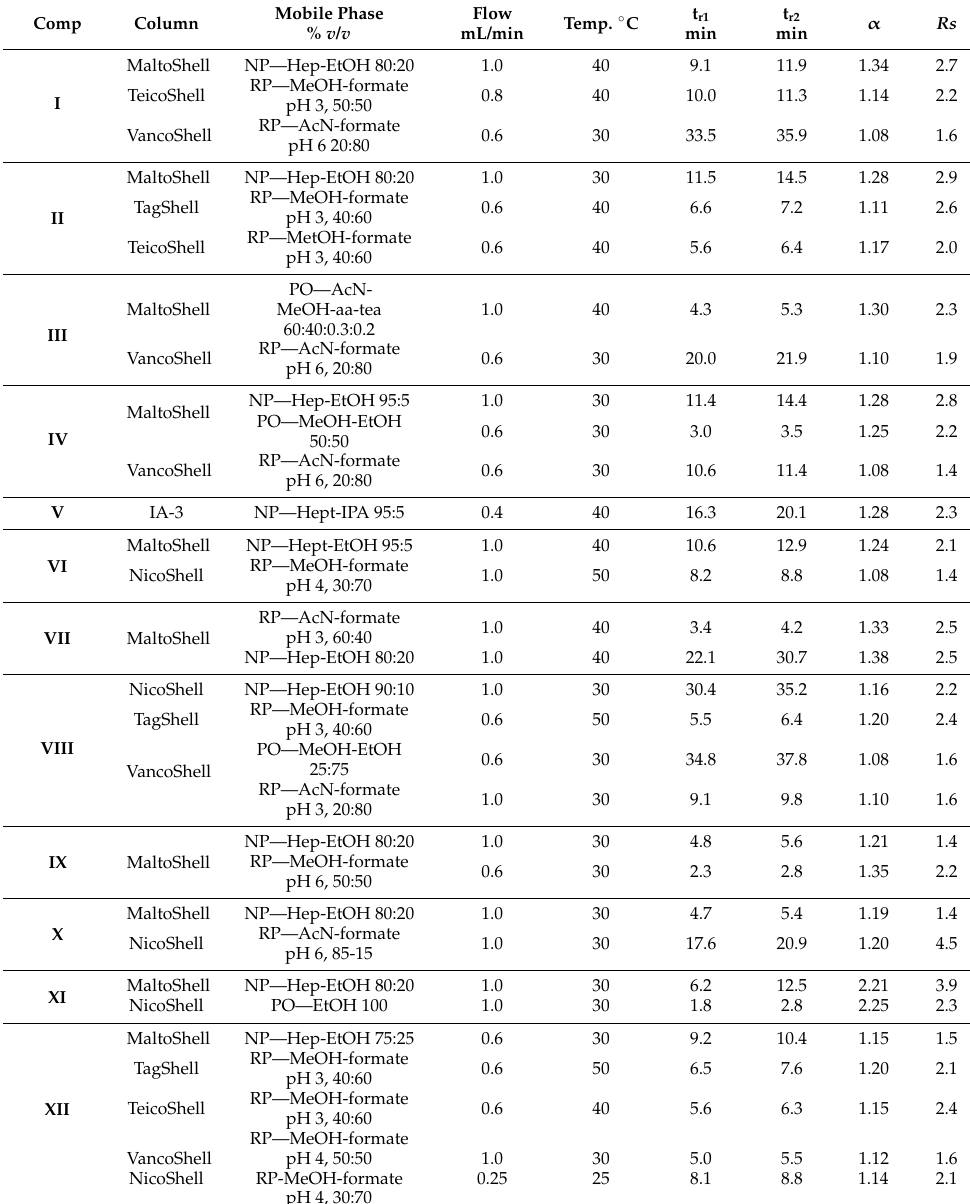
Table 2. Selected enantiomer separations of azole compounds whose structures are shown in Figure 1.